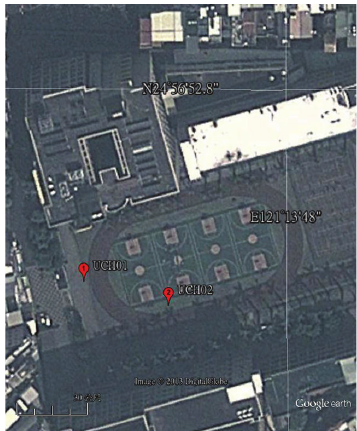
Figure 4: The image of UCH01 and UCH02 (image from Google with a proportional scale of 30 m).